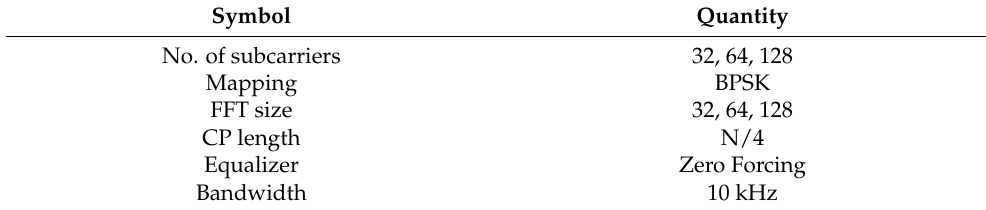
Table 3. Transceiver parameters.